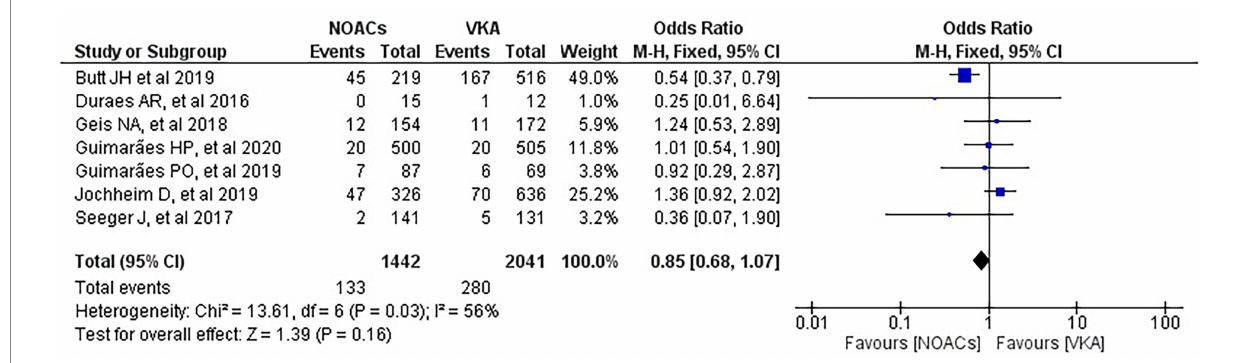
FIGURE 4 Forest plot of all-cause mortality for DOACs compared with VKA. M-H, Mantel–Haenszel test; CI, confidence interval.